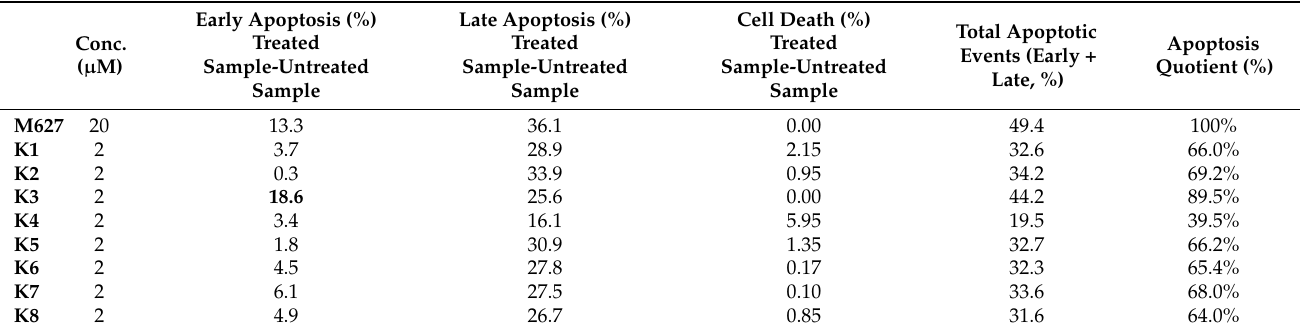
Table 7. Apoptosis induction by ketone-selenoesters on MDR Colo 320 adenocarcinoma cells. The 12 H - benzo( α )phenothiazine (M627) was applied as a positive control.